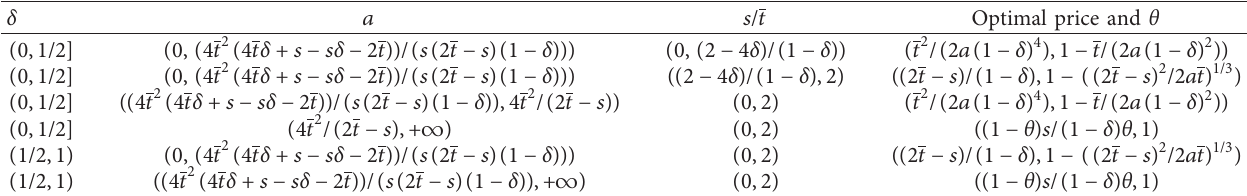
Table 5: The optimal price and θ